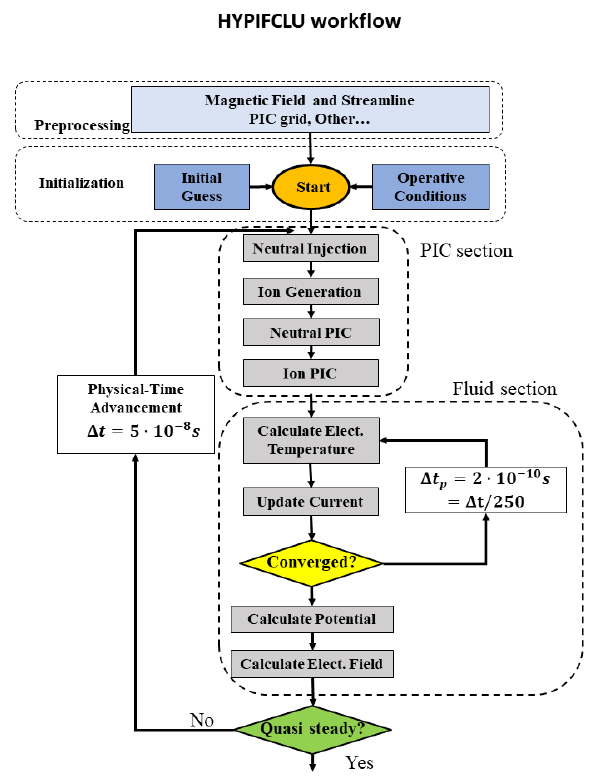
Figure 3. Flow chart of the HYPICFLU code. Typical integration time-steps are